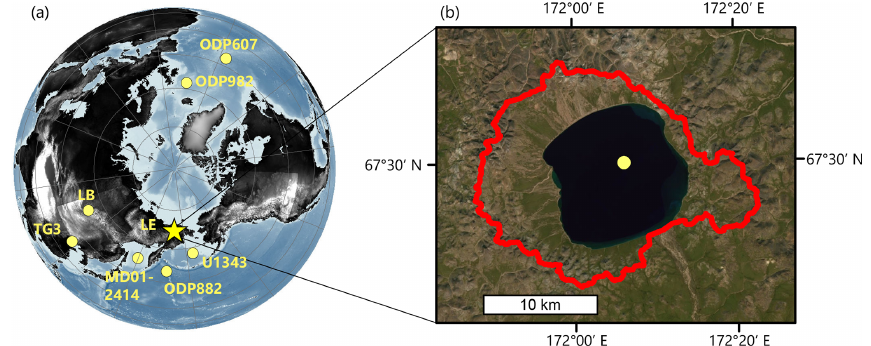
Figure 1. Study location. (a) Map showing the location of Lake El’gygytgyn (star) and other key sites discussed in the text (yellow circles) including Ocean Drilling Program (ODP) Sites 882 (Martínez-Garcia et al., 2010), 607 (Sosdian and Rosenthal, 2009), 982 (Lawrence et al., 2009) as well as International Ocean Discovery Program (IODP) Site U1343 (Kender et al., 2018), MD01-2414 (Lattaud et al., 2018), and Tianjin-G3 loess profile (Zhou et al., 2018). (b) Satellite image of Lake El’gygytgyn. The yellow dot represents the coring location of ICDP Site 5011-1 in the central lake basin, and the red outline designates the lake’s watershed. World imagery sources: Esri, Maxar, GeoEye, Earthstar Geographics, CNES/Airbus DS, USDA, AeroGRID, IGN, and the GIS User